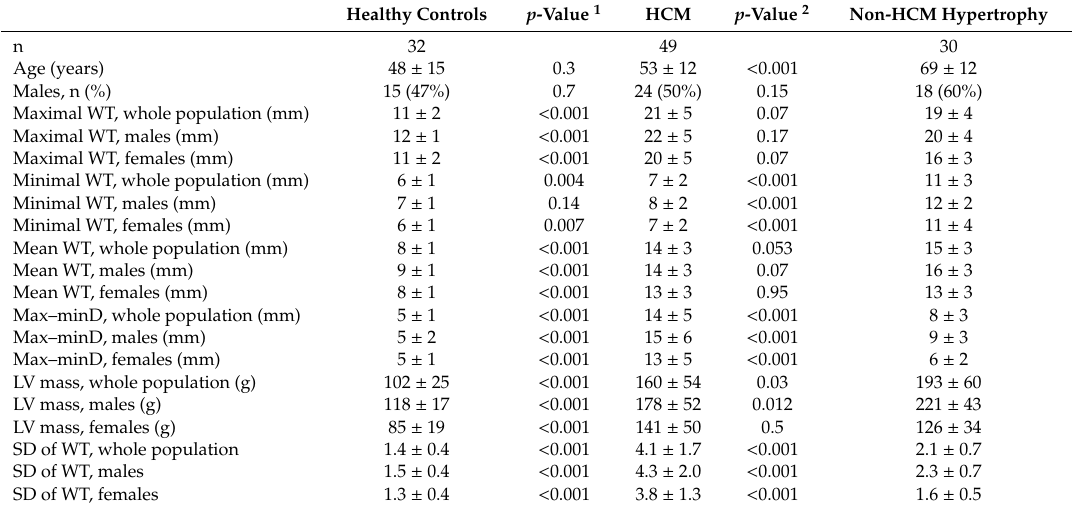
Table 1. Comparison of morphometric features between different groups.